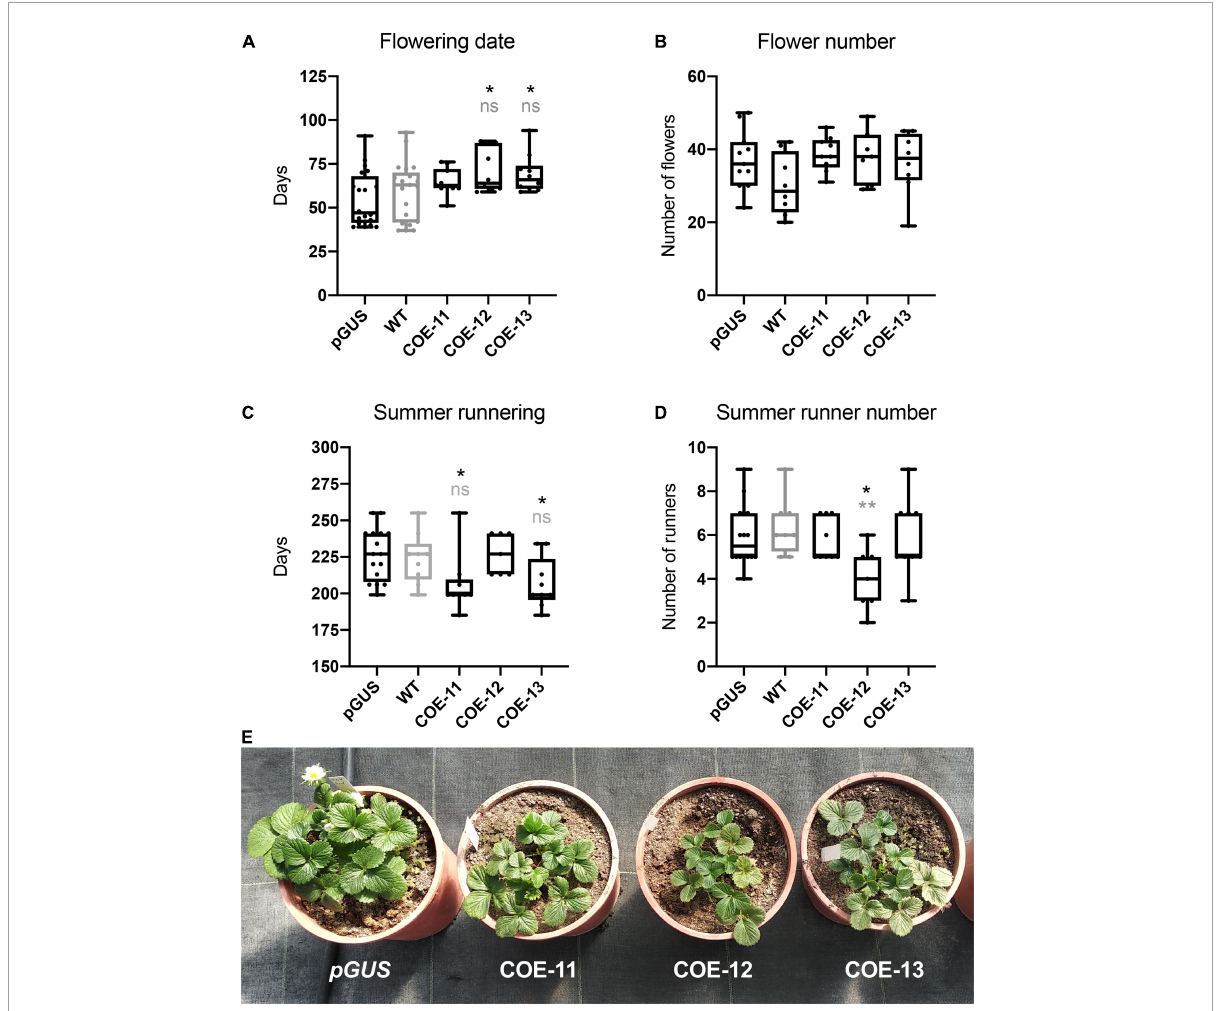
FIGURE3 Phenotype of 35S: FaCO lines (COE) in comparison to control plants. (A) Number of days to flowering from November 20th. (B) Total flower number (from November 20th until September 1st). (C) Number of days until the first summer stolon. (D) Number of runners per plant. (E) Phenotype of 35S: FaCO lines in comparison to control GUS plants. One representative replicates is shown. Boxes span the 25th and 75th percentiles and the middle line represents the median. Whiskers (T-bars) are the minimum and maximum values. Asterisks indicate significant differences between pGUS (in black) or ‘Camarosa’ wild type (WT; in gray) and 35S: FaCO overexpressor plants; statistical significance was determined by ANOVA and Tukey’s test ( ∗ P < 0.05, ∗∗ P <